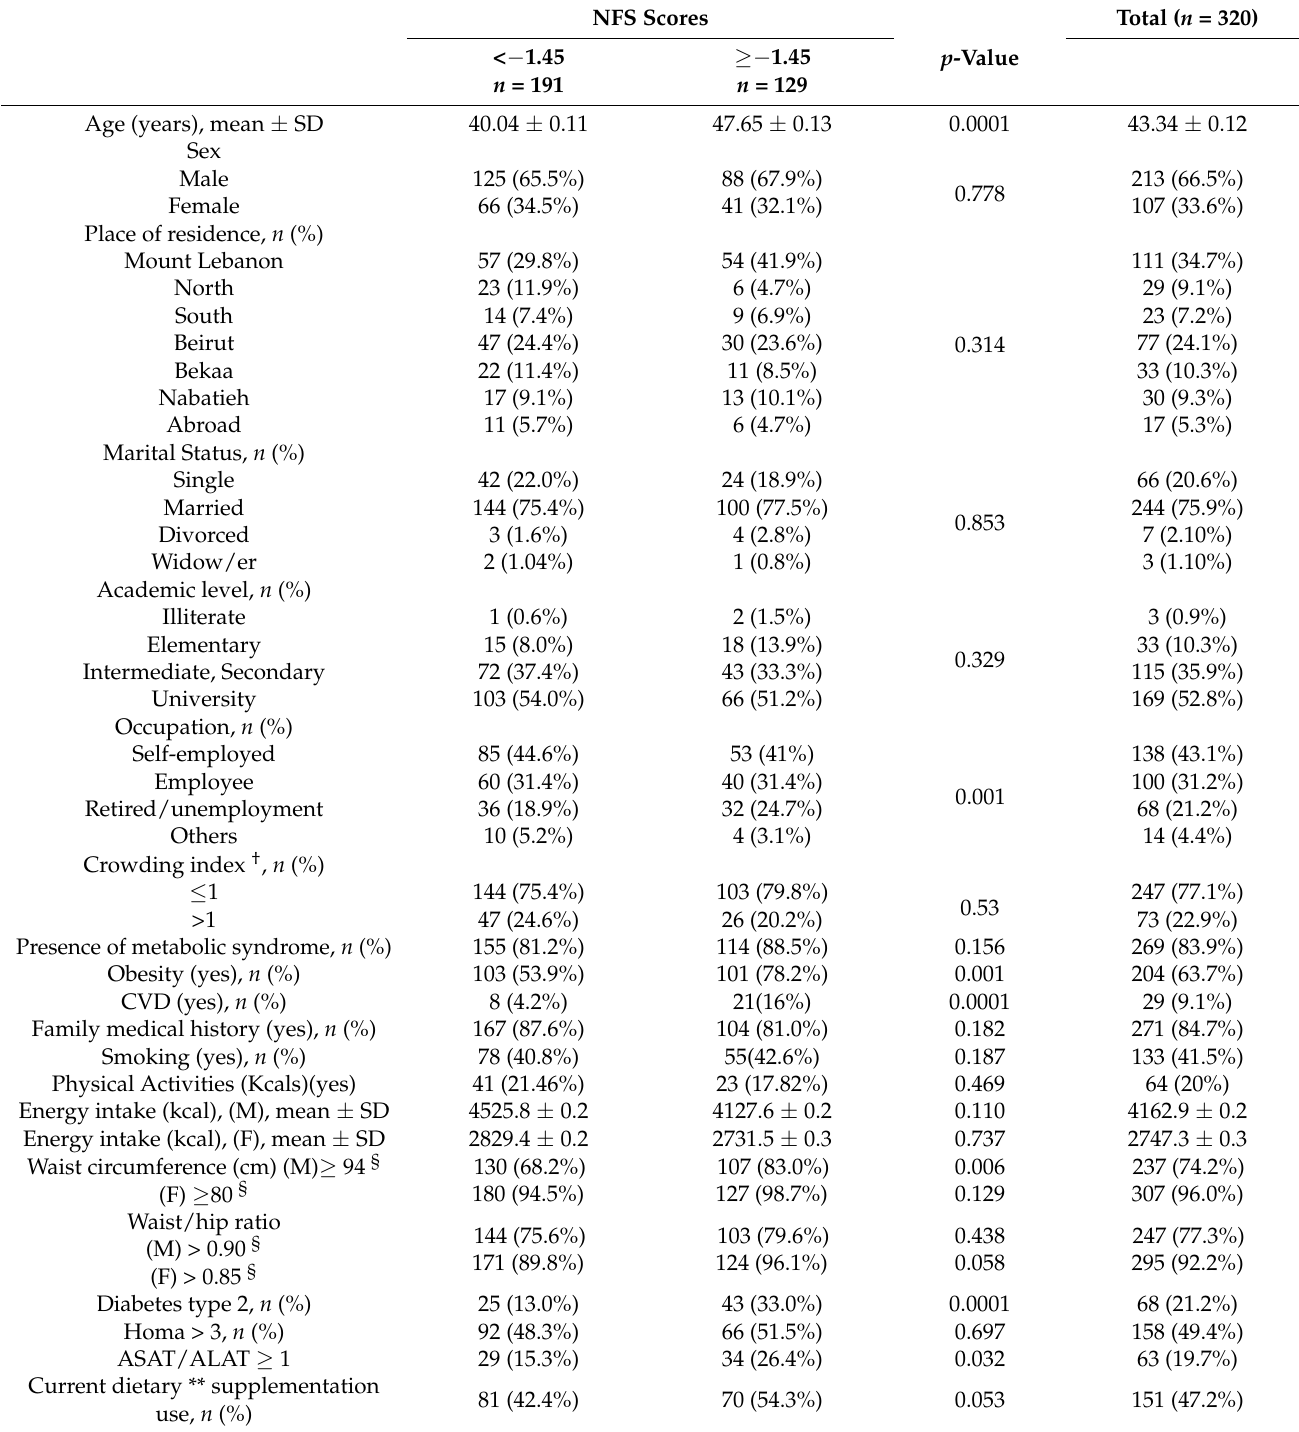
Table 1. Sociodemographic, clinical, and environmental parameters according to the NFS scores ( n =